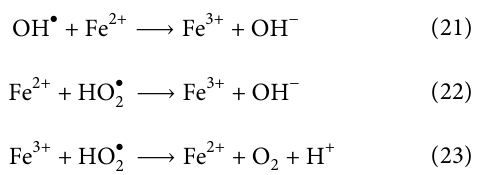
2 O 2 ] on % RCN and